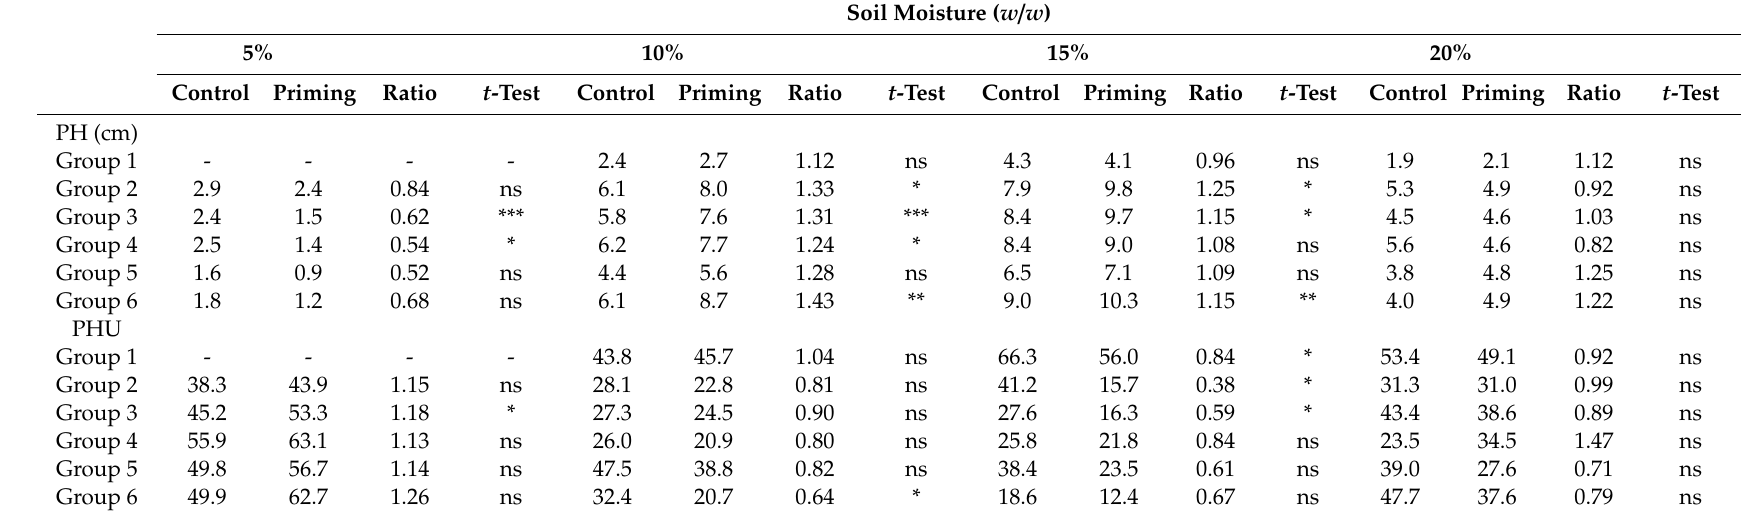
Table 4. E ff ects of priming on plant height (PH) and plant height uniformity (PHU) of six genotypic groups under four soil moisture